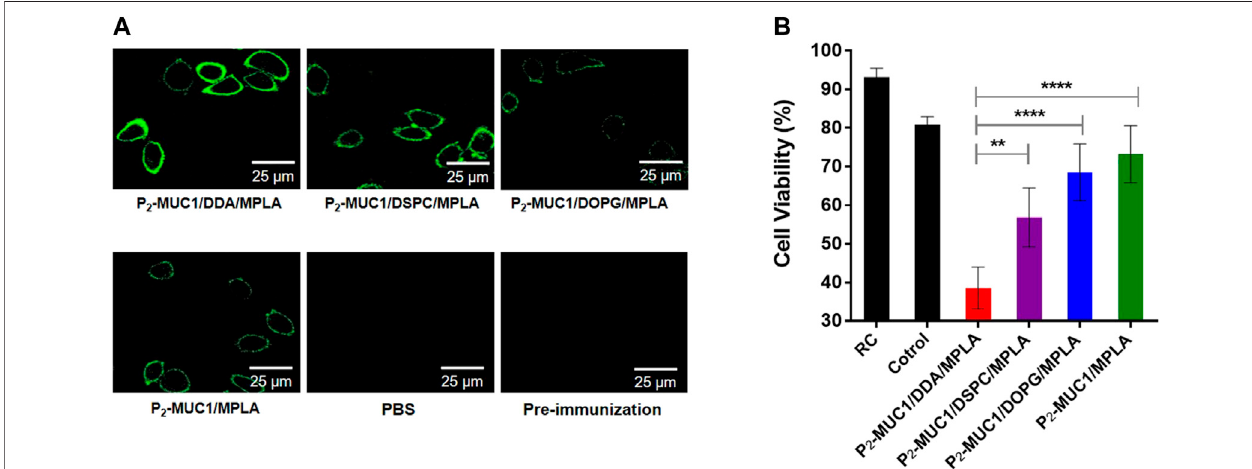
FIGURE4| MUC1-speci fi cantibodies recognizeMUC1-positivebreast cancercellline(MCF-7). (A) Confocal fl uorescence microscopy images ofthecellsstained withpre-immunization sera,sera from PBS and the thirdimmunization antisera collected from P 2 -MUC1/DDA/MPLA,P 2 -MUC1/DSPC/MPLA,P 2 -MUC1/DOPG/MPLA and P 2 -MUC1/MPLA group. (Scale bar = 25 μ m). (B) MTT test for complement-dependent cytotoxicity. Differences were determined by one-way ANOVA and Tukey ’ s HSD test (PBS was used as control). Asterisks indicate statistically signi fi cant differences (**** p < .0001, ** p < .01). Data are the mean SD of fi ve mice and are representative of fi ve independent experiments.